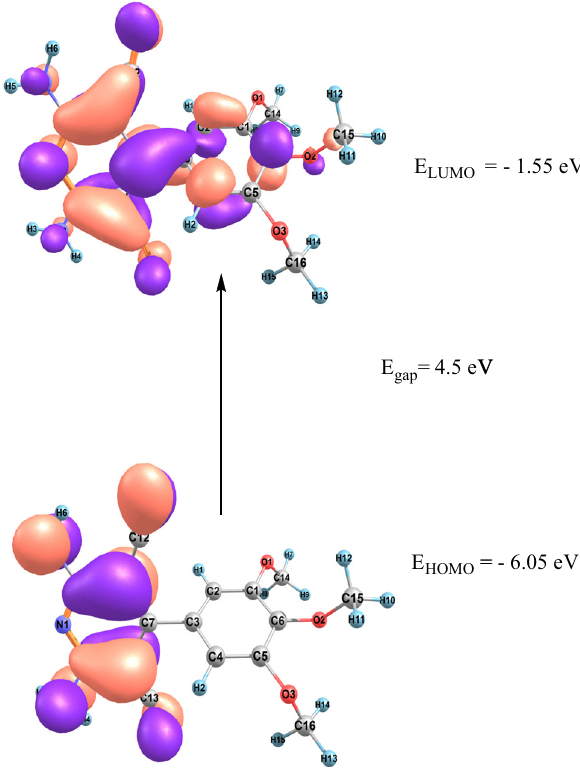
Figure 8: Representations of HOMO and LUMO orbital density of DTPP at B3LYP/6 - 31 G** level.